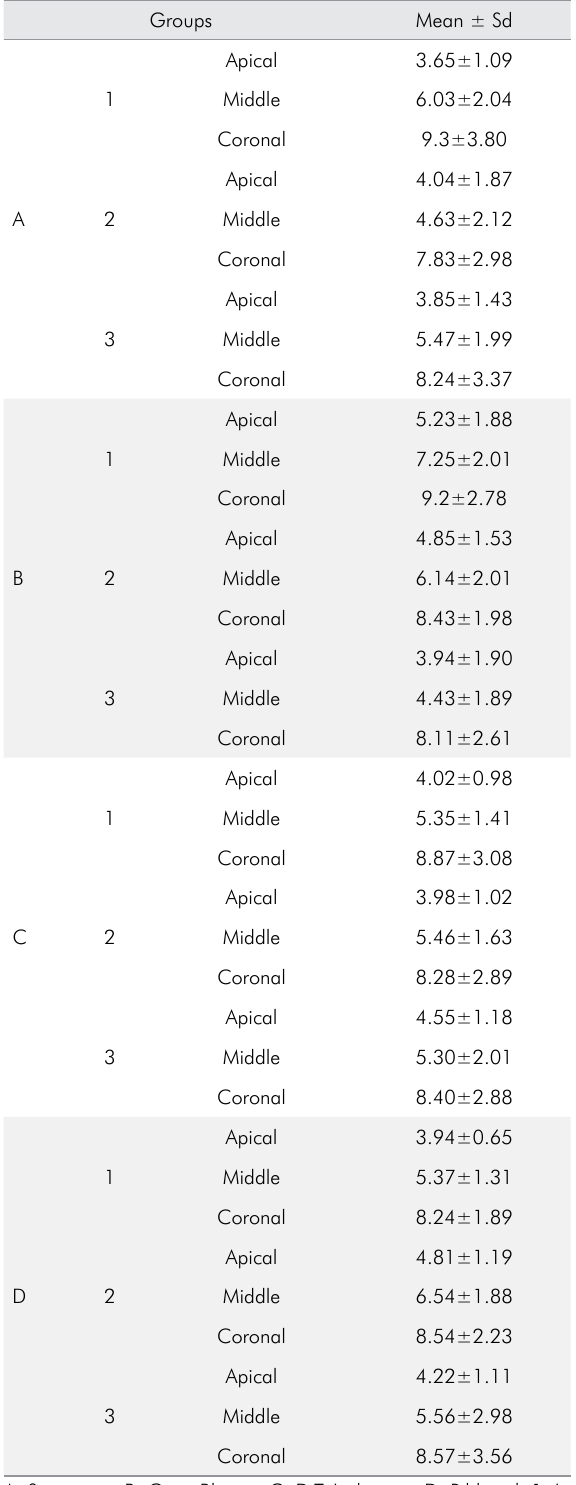
Table 3. Mean and standard deviations of the microtensile bond strength of the study